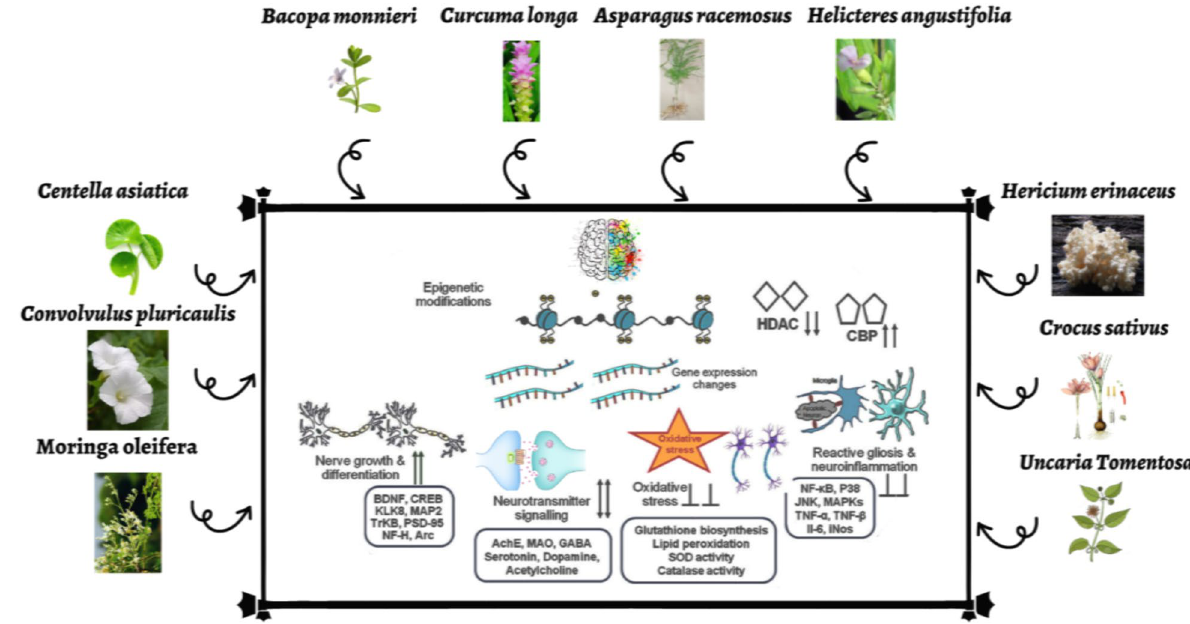
Fig. 3 Schematic representation of the biochemical events that cause neurodegenerative disorders